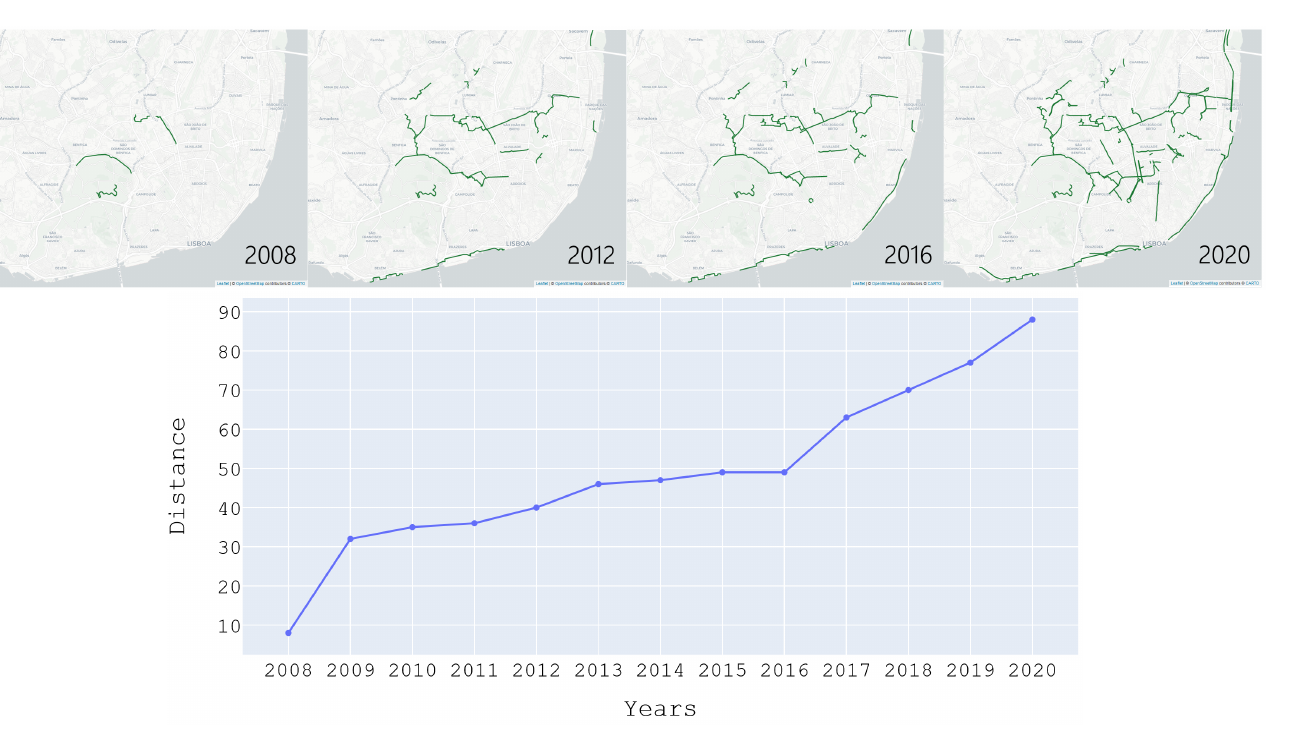
Figure 3. Evolution of Lisbon’s cycling network between 2008 and 2020 and its total distance in km